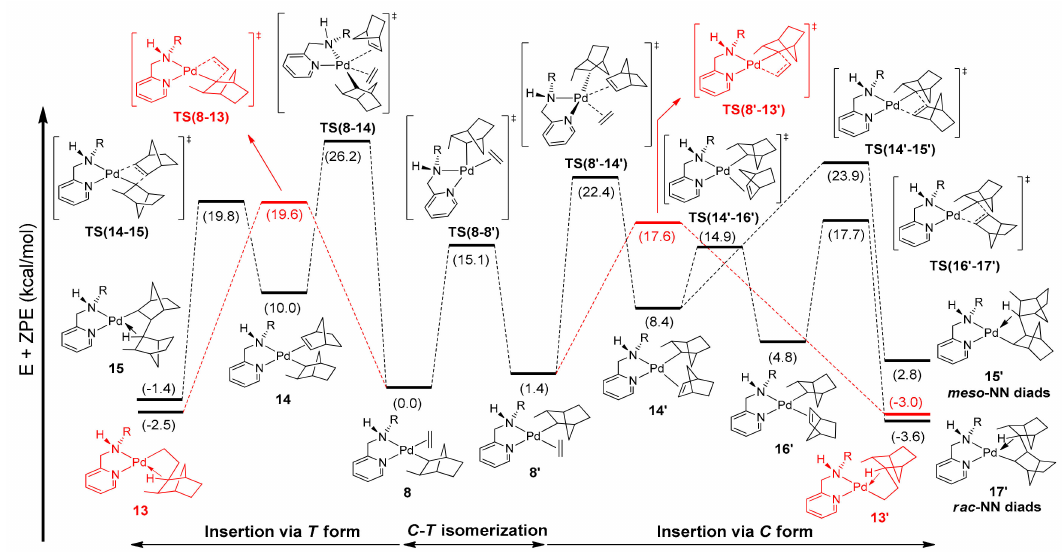
Figure 5. Energy profile for isomerization, ethylene and norbornene propagation reaction of 8 and 8’ (E + ZPE, kcal/mol). (R = 2,6- i Pr 2 C 6 H 3